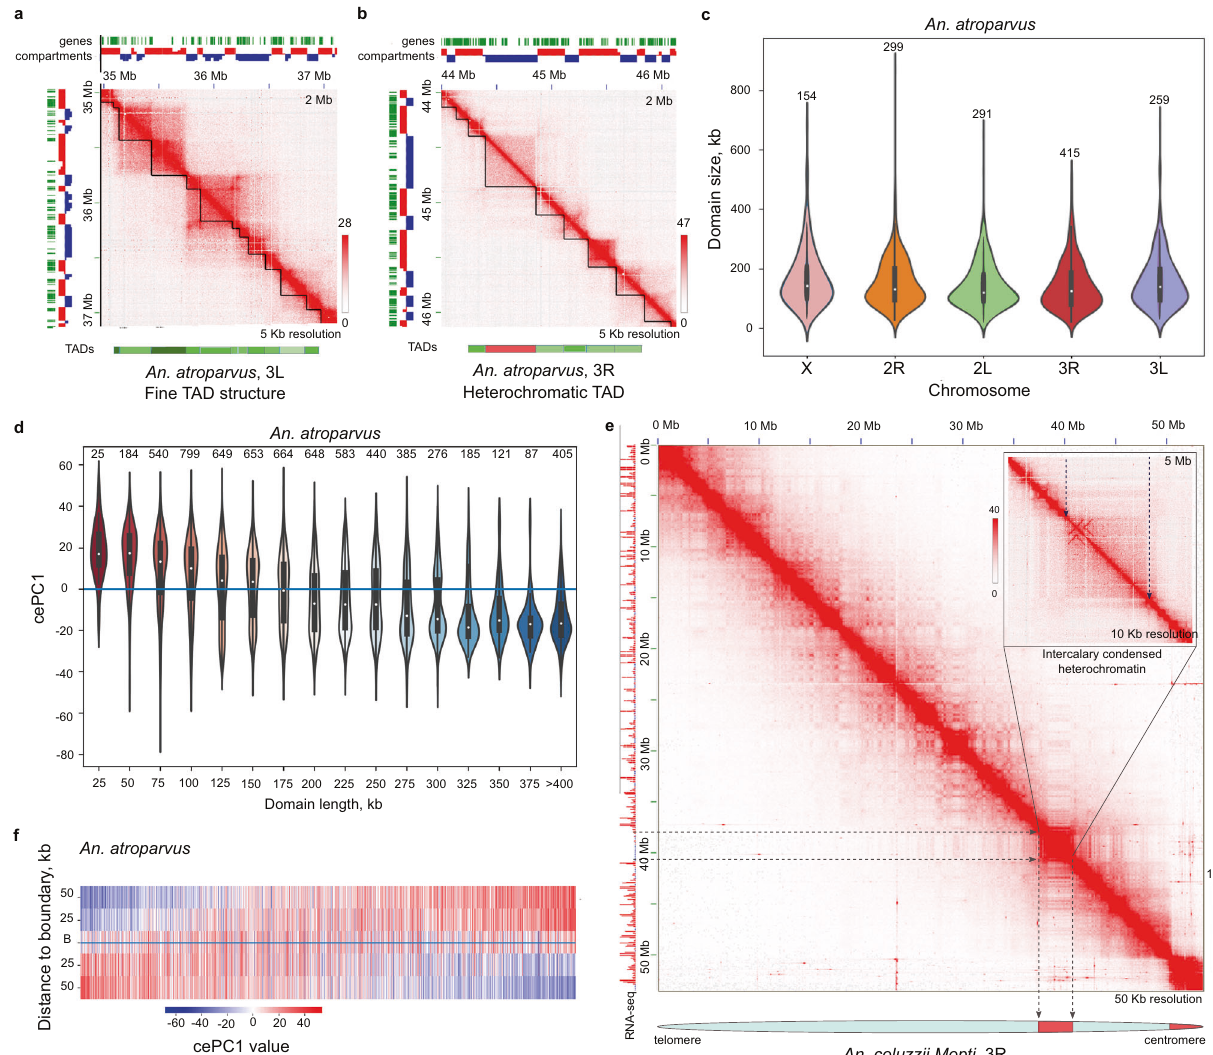
Fig. 6 TADs in Anopheles genomes. a Typical TADs structure; b Example of heterochromatic TAD (marked in red below the contact map region); c TADs size distributions within the chromosomes, total number of TADs: n = 1418; d Violin-plot illustrating the distributions of cePC1-values strati fi ed by TADs length. Center and bounds of box correspond to Q1, median, and Q3; whiskers extend between Q1 – 1.5IQR and Q3 + 1.5IQR; e Compact intercalary heterochromatic block visualized on the Hi-C map of Chr 3R An. coluzzii ; f Heatmap of cePC1 values around TAD boundaries. Each line represents one TAD boundary. a – d , f show data for An. atroparvus . Data for other species are shown in Supplementary Fig. 9. Color bars on a , b , e panels re fl ect the contact